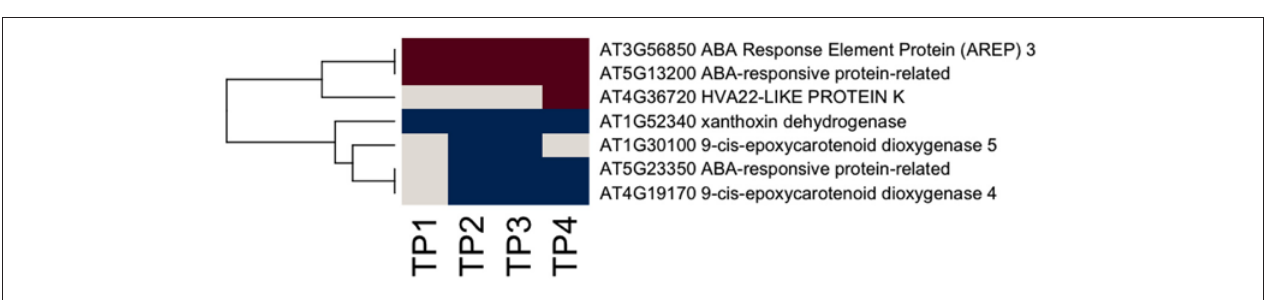
expression changes, blue cells represent significant negative changes, and off-white cells represent no change or no statistically significant